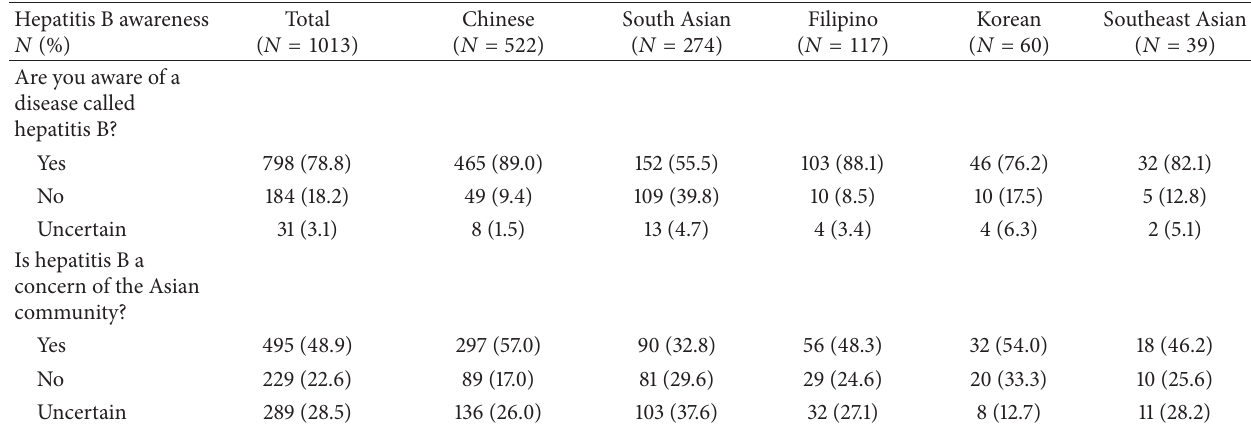
Table 2: HBV awareness of survey respondents.